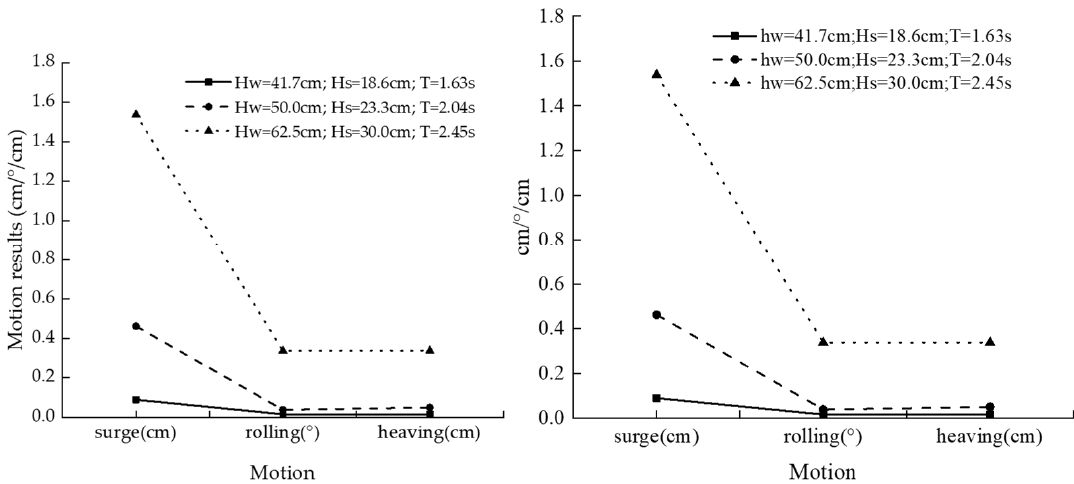
Figure 12. Motion of the platform under waves of large wave height.